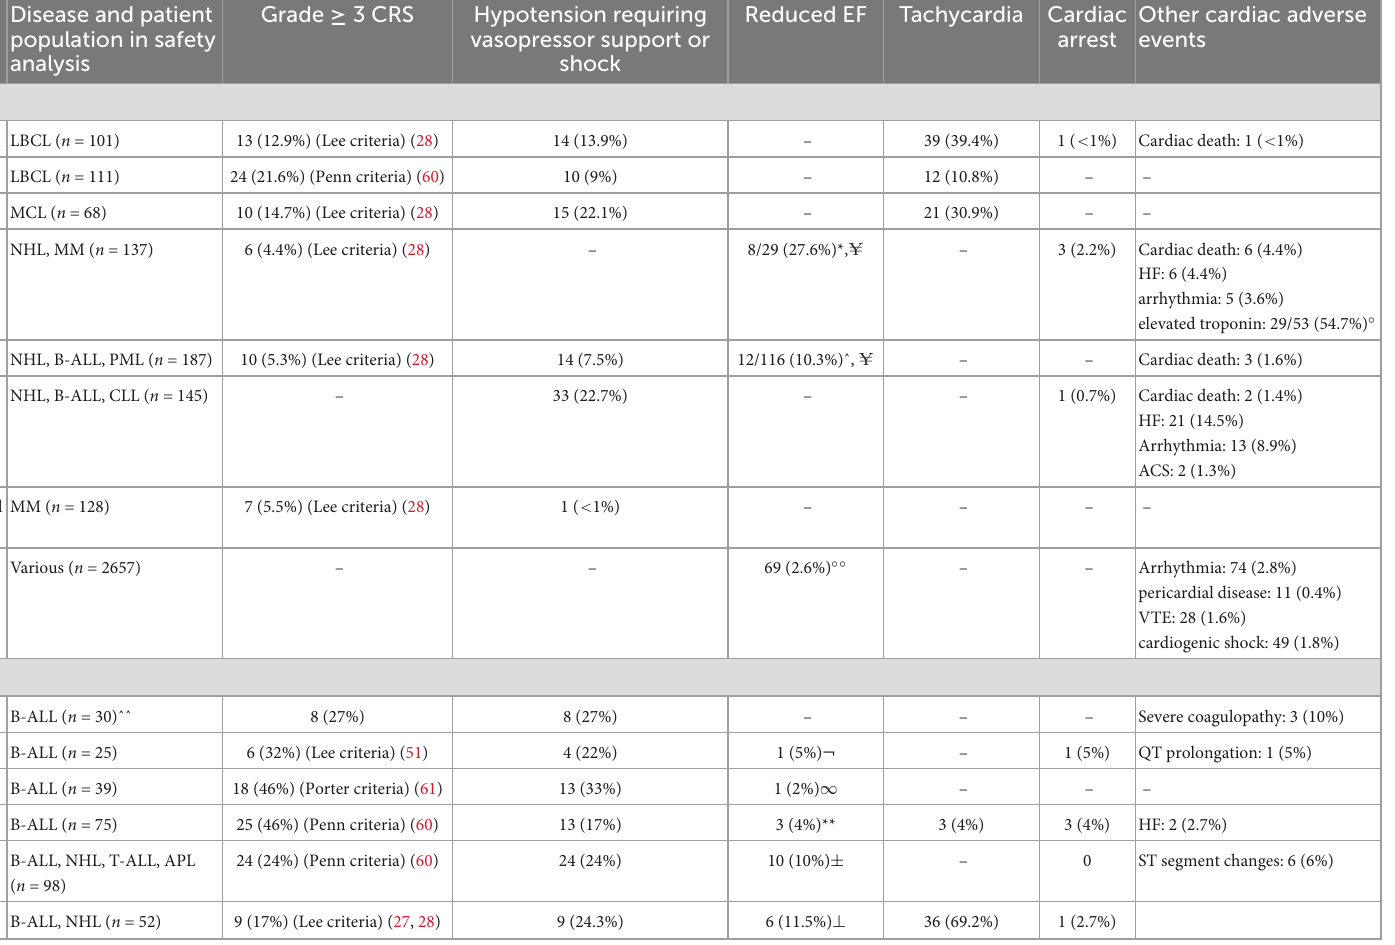
TABLE 1 Summary of cardiovascular adverse events reported in studies enrolling adult and pediatric